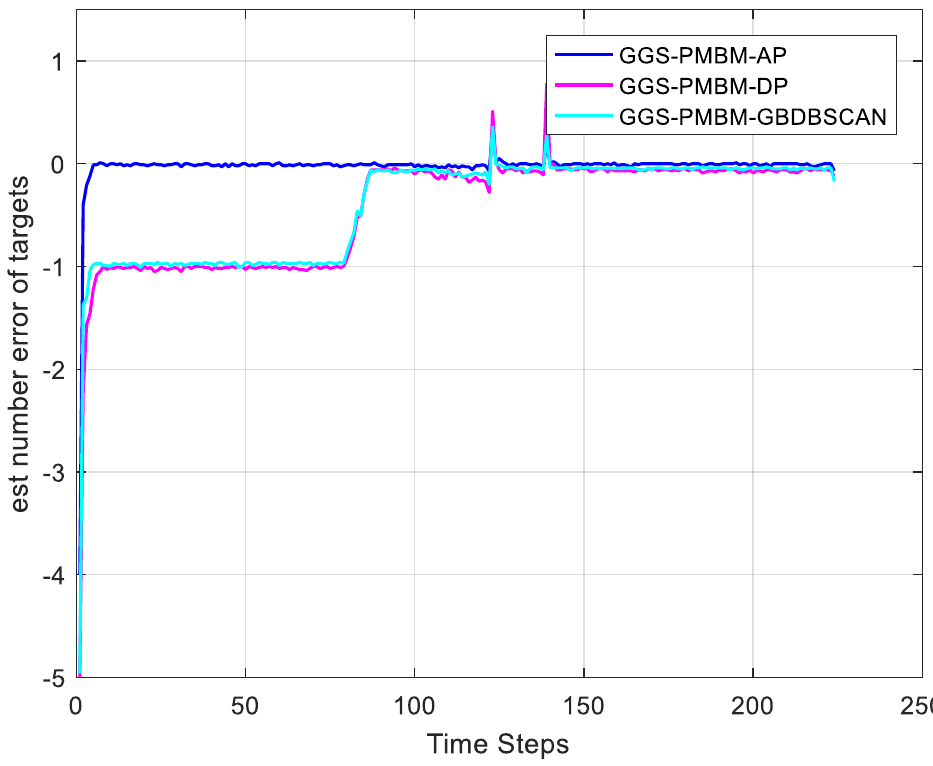
Figure 13. Averaged cardinality error of the GGS − PMBM − AP filter, GGS − PMBM − DP filter and GGS − PMBM − GBDBSCAN over 100 Monte Carlo runs. Table 4. Average computational times.